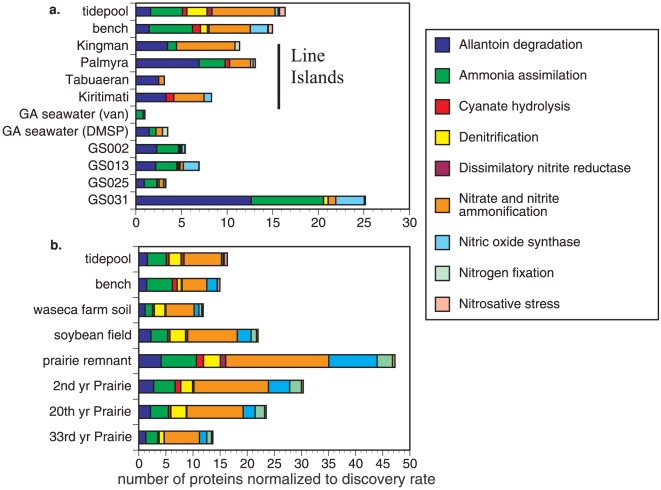
The number of proteins matched to nitrogen metabolism functions among multiple metagenome studies.a. marine metagenomes and b. soil metagenomes. To facilitate comparison among studies, the number of matches is normalized to the ‘discovery rate’ for proteins in the dataset (number of protein matches per 100 fragments). For a. the marine metagenomes are as in Table 2, while b. uses Midwestern soil metagenomes (MG-RAST ids 4441091.3, 4442657.3, 4442656.3, 4442658.3, 4442659.3, 4441281.3, respectively).